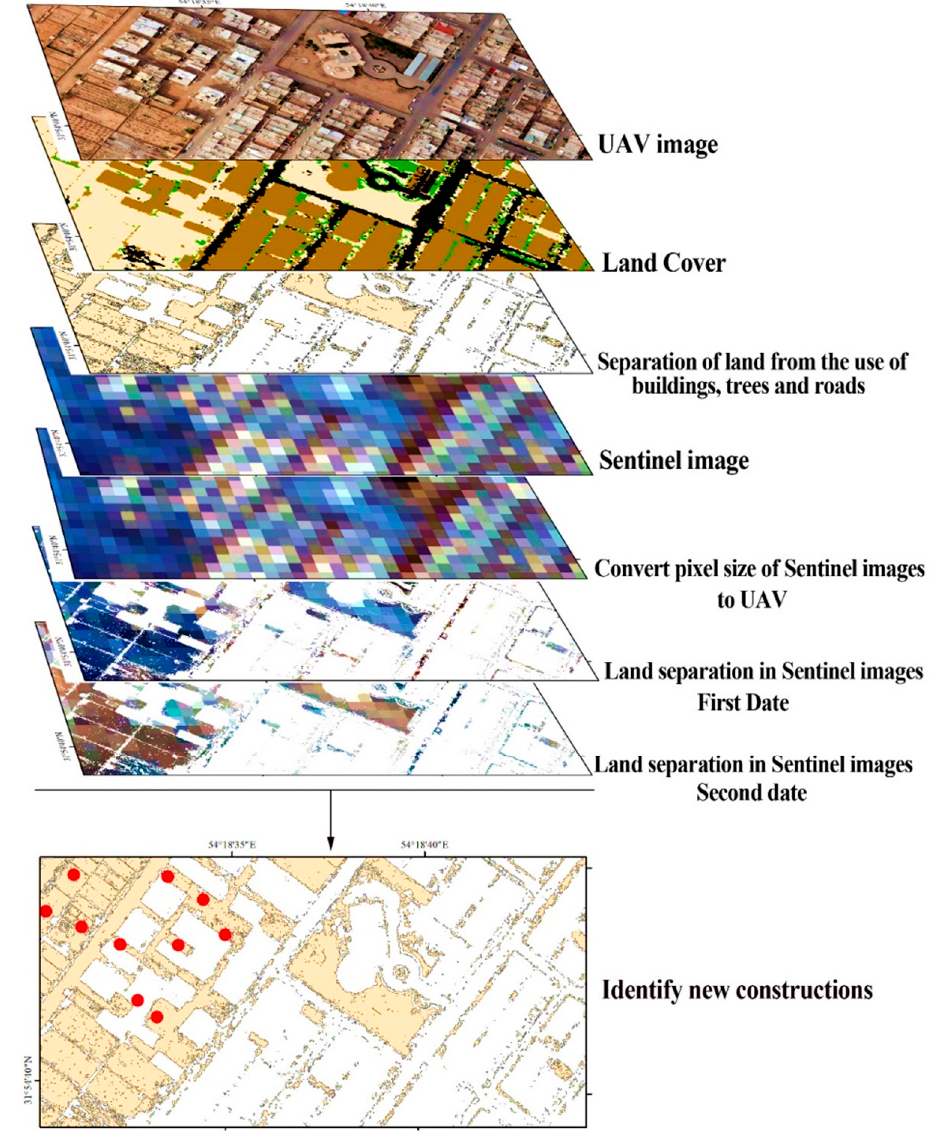
Figure 9. General framework of the proposed method for identification of new constructions in urban areas.